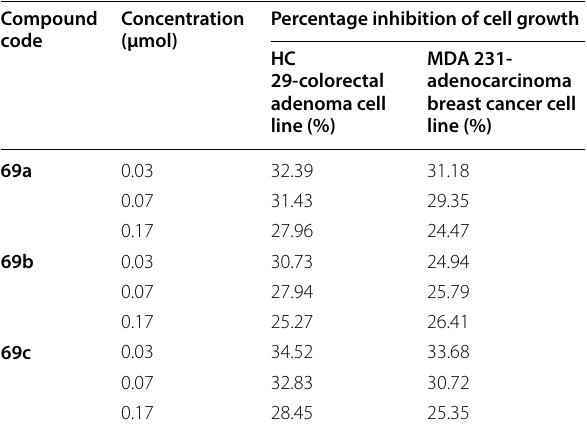
Table 14 Anticancer activity of the title compounds (69a–